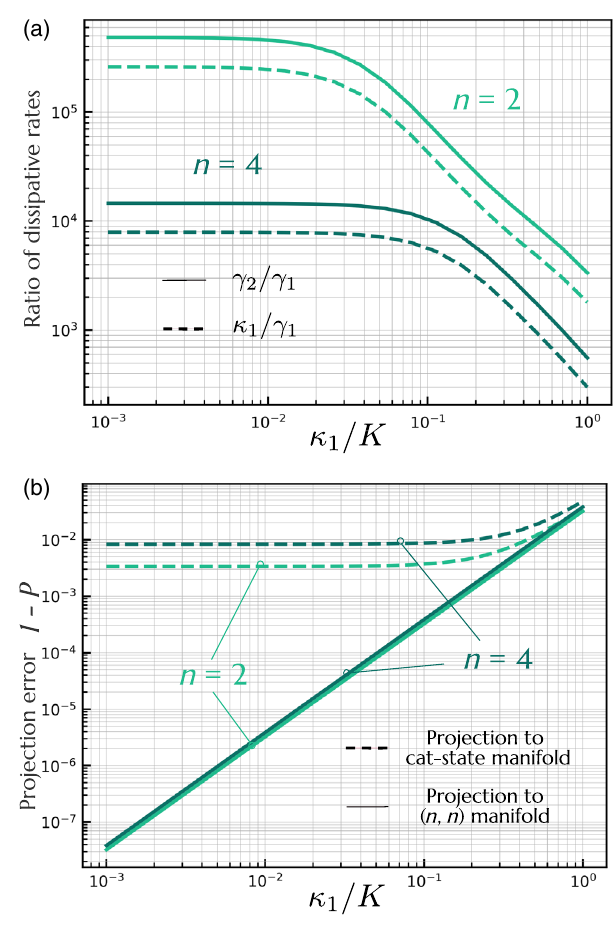
FIG. 8. Slow dynamics near generalized bistable regimes. (a) Solid line: Ratio of the two smallest relaxation rates (i.e., dissipative rates of the system Liouvillian L 0 ) as a function of κ 1 . Dashed line: κ 1 = γ 1 . κ 1 → 0 corresponds to being at a bistable parameter point ð r 1 ; r 2 Þ ¼ ð n; n Þ , either n ¼ 2 (light green) or n ¼ 4 (dark green). Parameters are Λ 2 ¼ 6 K , Λ 3 ¼ κ 2 ¼ 0 , ffiffiffiffiffiffi p Δ ¼ nK= 2 , and Λ − in Λ = 2 . One sees that the slow rate 1 ¼ 2 γ κ 1 is much slower than 1 and that there is a pronounced dissipative gap. (b) Solid line: The measure 1 − P [cf. Eq. (76)] of how closely the slowest system decay mode (with rate γ 1 ) corresponds to dynamics in the bistable manifold. Dashed lines: Same, but measuring how closely this mode is described by coherent states centered at the semiclassical stable